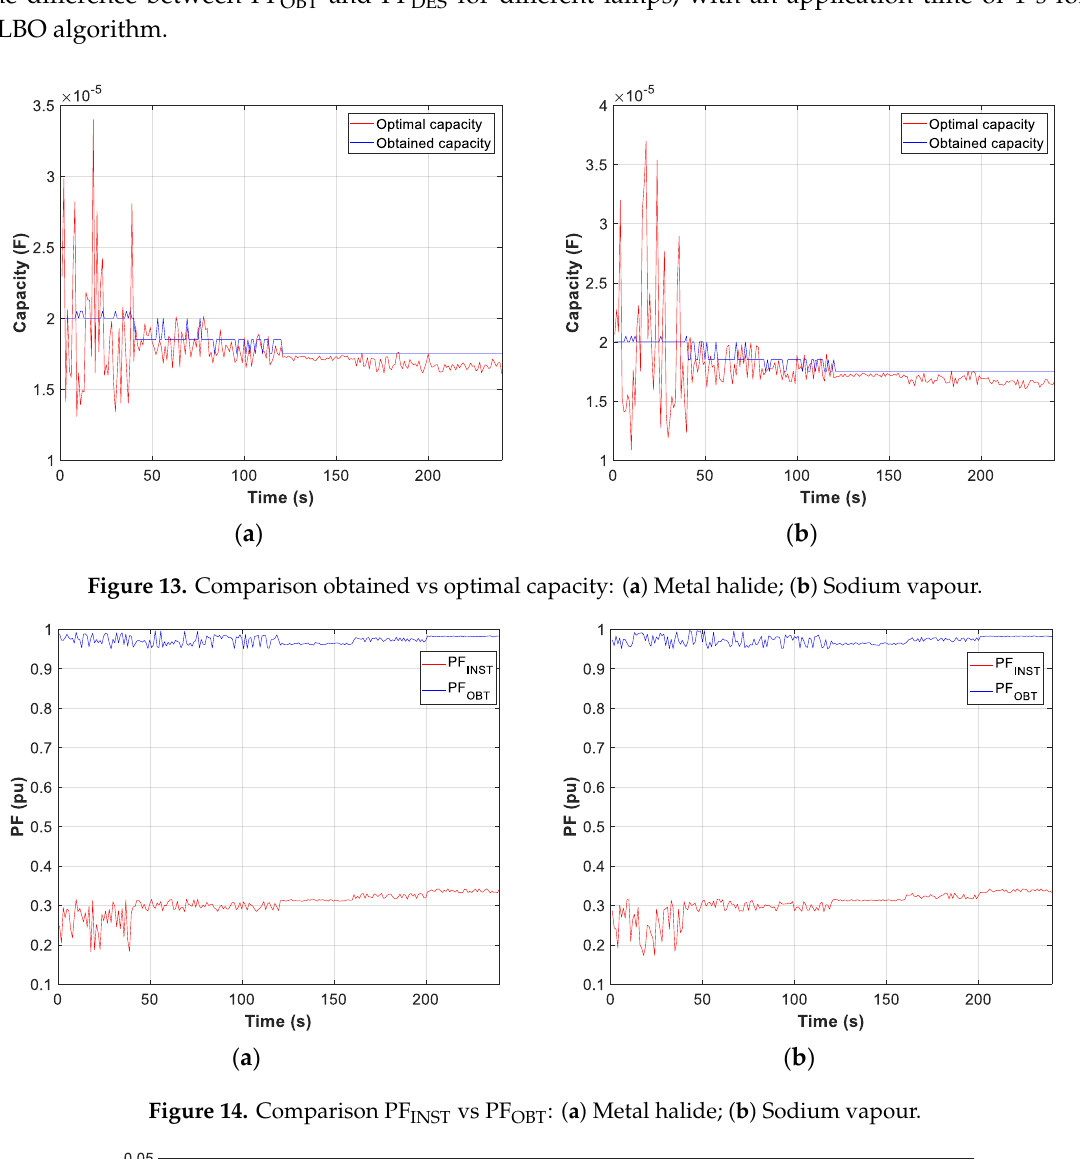
Figure 14. Comparison PF INST vs PF OBT : ( a ) Metal halide; ( b ) Sodium vapour.